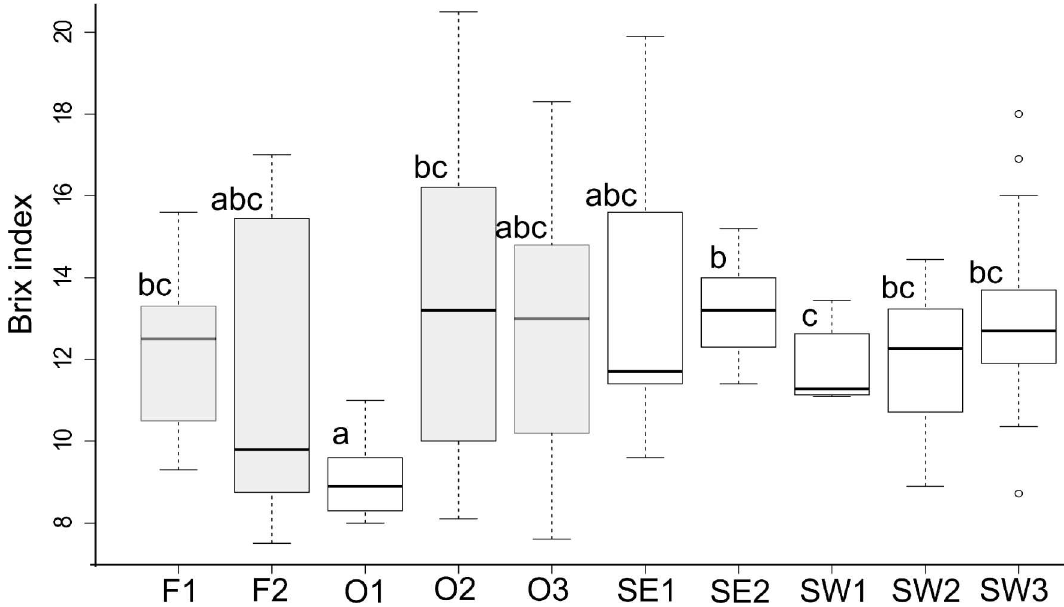
Fig 3. Boxplot of Brix index amongst sites around Tasmania. The boxes enclosedata falling betweenthe 1 st and 3 rd quartileand the lines in boldrepresent the medianin each location.The bars indicatethe 95% confidenceintervals of the median.Data points falling outsidethese rangesare plotted individually.Different letters above the bars indicate significant differences betweensites. Grey boxes represent sites with shallow water red lobsters (except site O1, with shallowwater brindlelobsters), while white boxes represent sites with deepwater brindlelobsters.